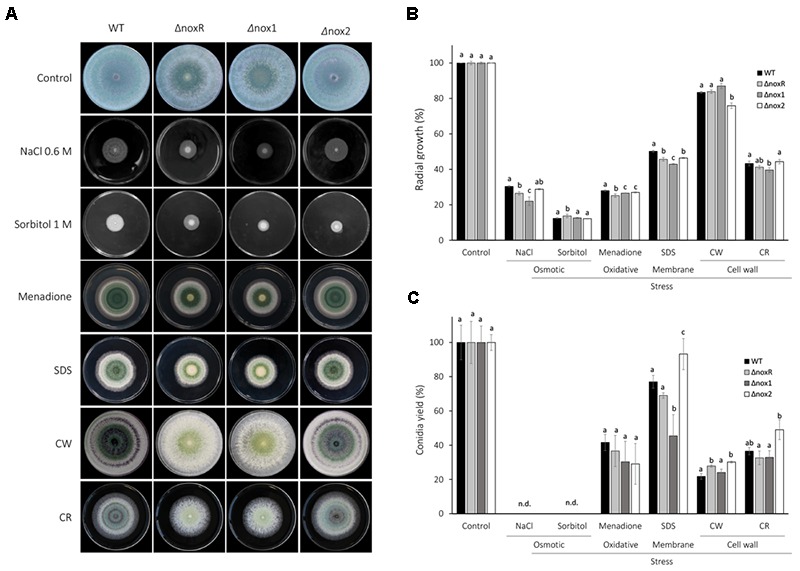
Stress response of T. atroviride nox mutants. (A) 5 μl containing 1 × 106 conidia were inoculated to the center of PDA plates, supplemented with the indicated stressors (see Methods for concentrations), and incubated at 25°C for 4 days. (B) The graphs display the relative values of mycelial growth, and (C) conidiation on a percentage scale. The mycelial growth was assessed as an inverse function of the growth speed, which was estimated by the number of days that a colony took to reach the edge of the plate; the highest of these inverted values was assigned as ‘100%’ and the remaining values were set as a fraction (%) of it. For conidiation, the conidia were collected and counted after 7 days of incubation at 25°C; the highest number of spores per treatment was set as ‘100%,’ with the remaining counts set as a fraction of it. The plotted values are the mean of three plates; the experiment was repeated three times with the same results. Statistics was based on Fisher’s test at 5% probability; different letters on top of bars indicate statistically significant differences among strains within each treatment of stressing agent. SDS, Sodium dodecyl sulfate; CW, Calcofluor White; CR, Congo Red.